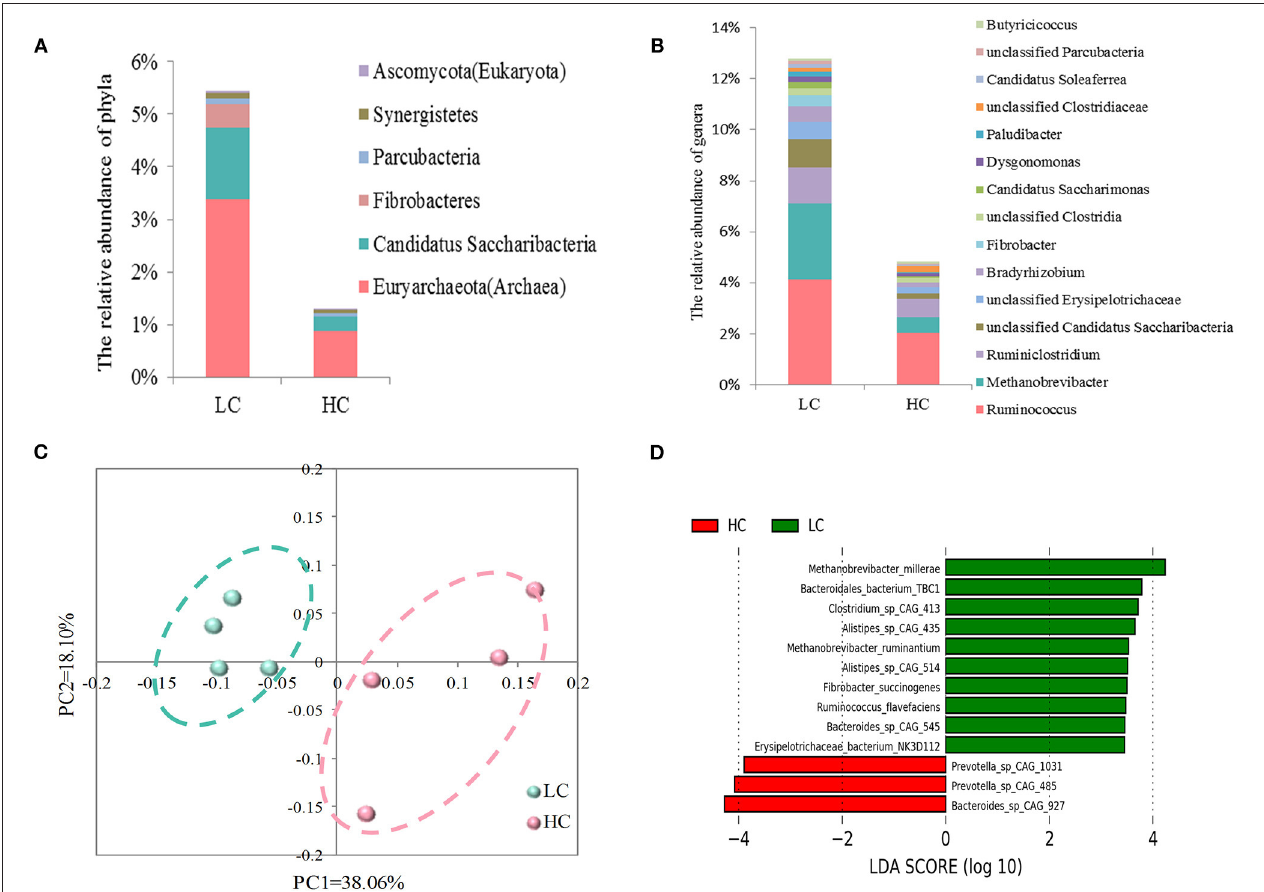
FIGURE 2 | Effects of high-concentrate (HC) diets on the fecal microbial communities in dairy cows at different taxonomic levels. Comparison of the fecal microbial communities at the level of phylum (A) and genus (B) . Only the phyla and genera that were significantly affected by dietary treatments were presented. (C) The principal coordinate analysis (PCoA) of fecal microbial functions at the species level. (D) Histogram of linear discriminant analysis (LDA) scores for abundant species between the LC and HC